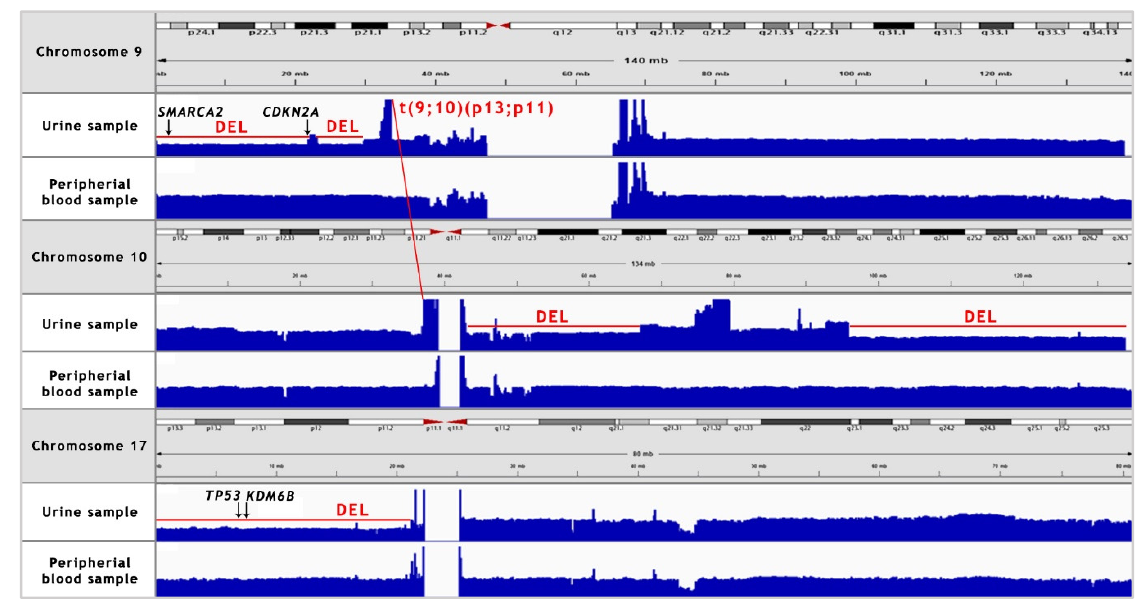
Figure 4. NGS coverage visualisation of the copy number variations (CNV’s) of chromosomes 9, 10 and 17 in the urine sample, as compared to the peripheral blood sample. A manual analysis enabled to confirm the deletion of 9p21 locus. Additionally, 9p22–24 deletion, two major deletions in long arm of chromosome 10, 17p deletion and translocation between chromosomes 9 and 10 were recognised. “DEL” stands for deletion.